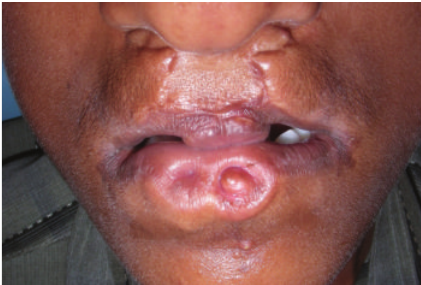
Figure2:Close-upviewshowingtwobilaterallysymmetricallippits on the lower lip.